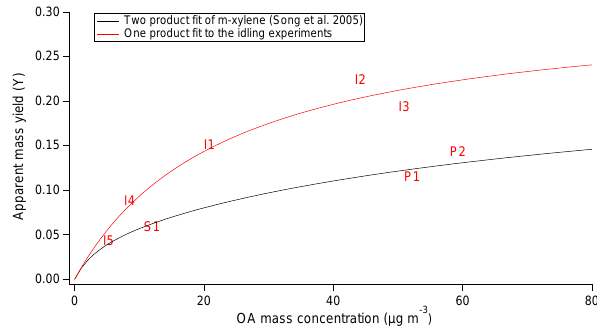
Fig. 5. The apparent mass yield (Eq. 2) from the gasoline exper- iments plotted against the concentration of organic aerosol mass. The red line represents a one product fit, ( Y = C OA (a 1 · k 1 /(1 + k 1 · C OA ), where a 1 = 0 . 311 and k 1 = 0 . 043) to the apparent mass yield for experiments I1–I5. The black line is a two product fit to the m- xylene yield from Song et al. (2005), (scaled by 0.88 and assuming a density of 1.4gcm − 3 ) to fit the precursor experiments carried out in this study. I1–I5 represents idling, S1 cold start and P1-P2 the precursor